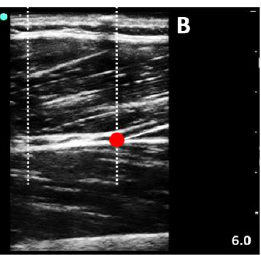
Figure 2. Representative ultrasound image of the vastus lateralis at rest ( A ) and during a maximum voluntary isometric contraction ( B ) in a seated position with the knee flexed at 60°.